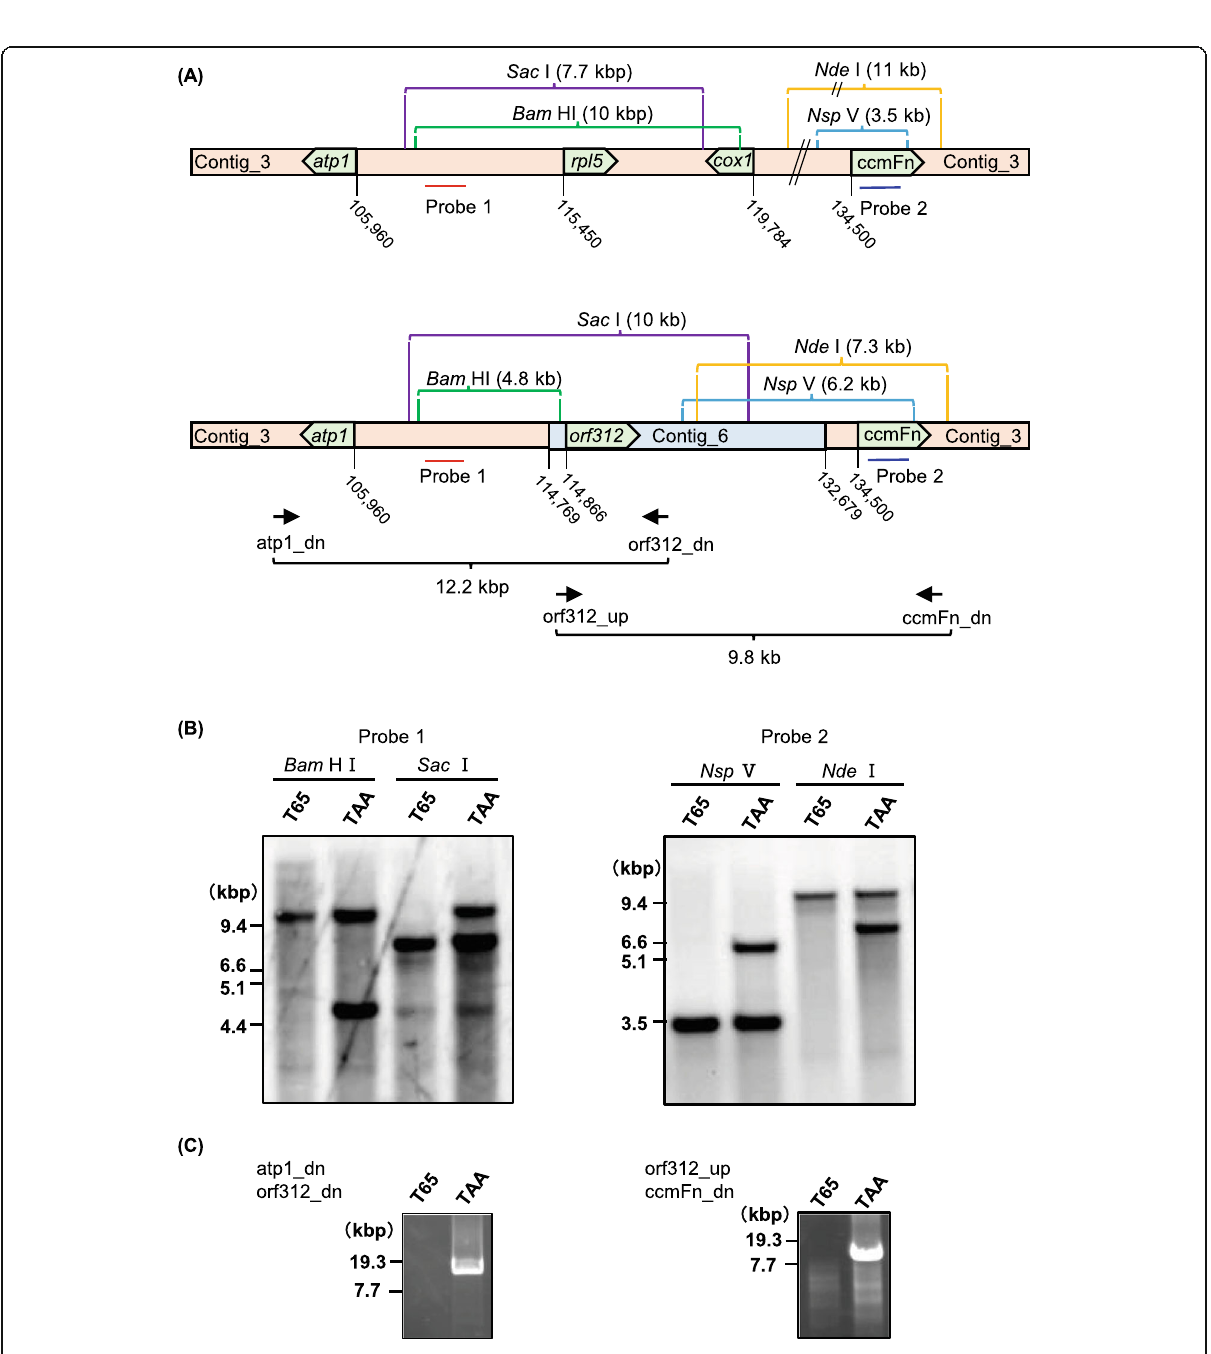
Fig. 4 Schematic genomic structure around orf312 . a Structure of contig_3 and linkage between contig_6 and contig_3. Nucleotide positions in subgenome-1 are indicated. b Southern blot analysis performed to detect the presence of the two genomic structures shown in panel A. The probes are indicated in panel A. c PCR performed to detect the linkages between orf312 and atp1 or